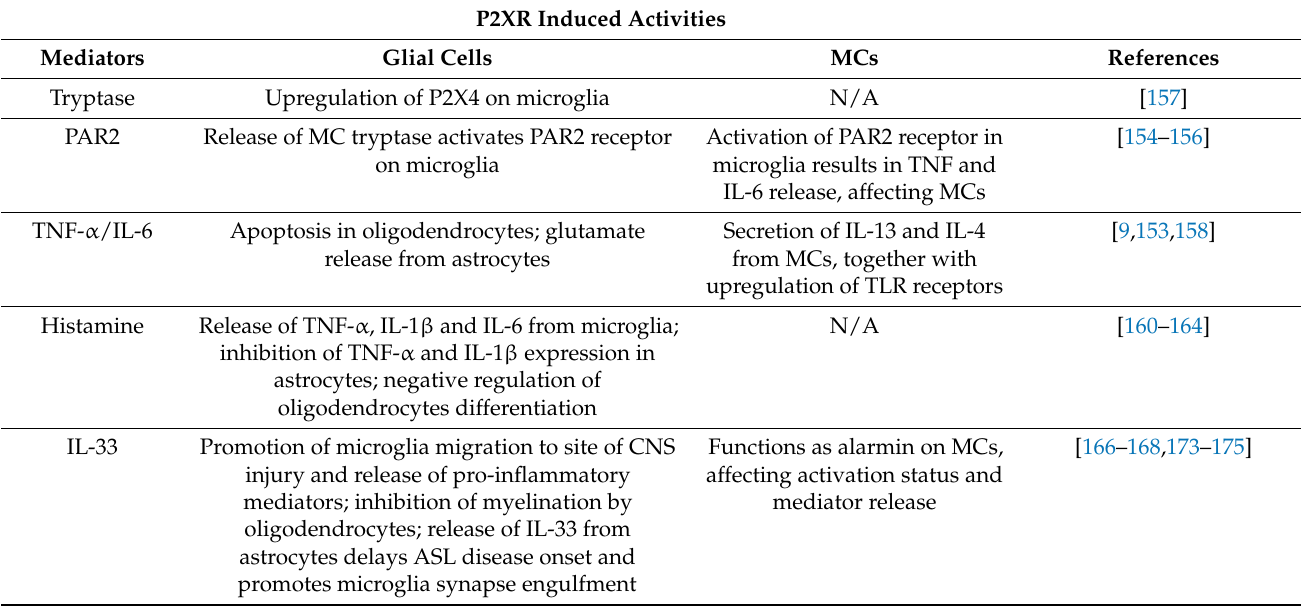
Table 3. MCs and glial cells activities induced by P2XR